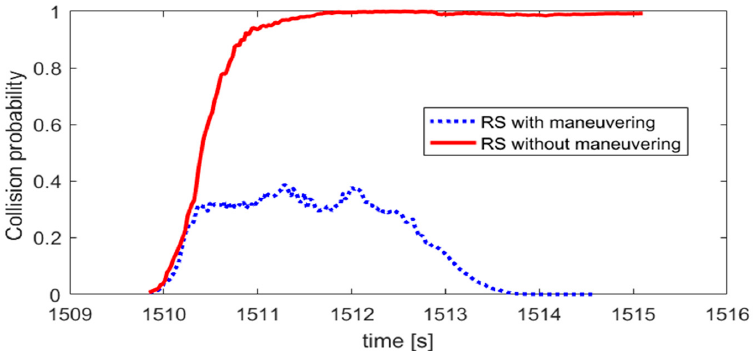
Figure 9. Prediction of collision probability between NCSO and RS.